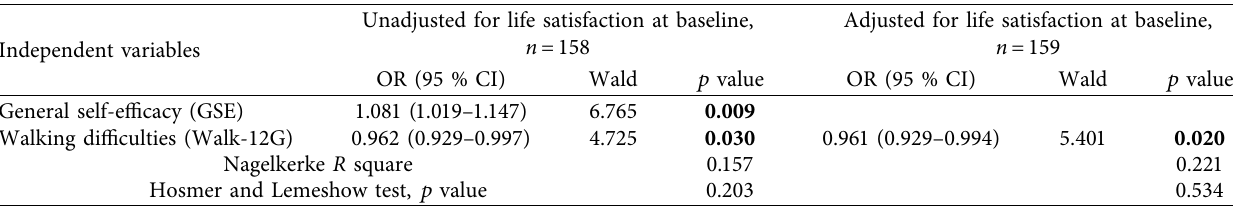
Table 2: Model 1: multivariable logistic regression analyses with life satisfaction (3-year follow-up) as the dependent variable (personal factor and motor-related aspects as independent variables).